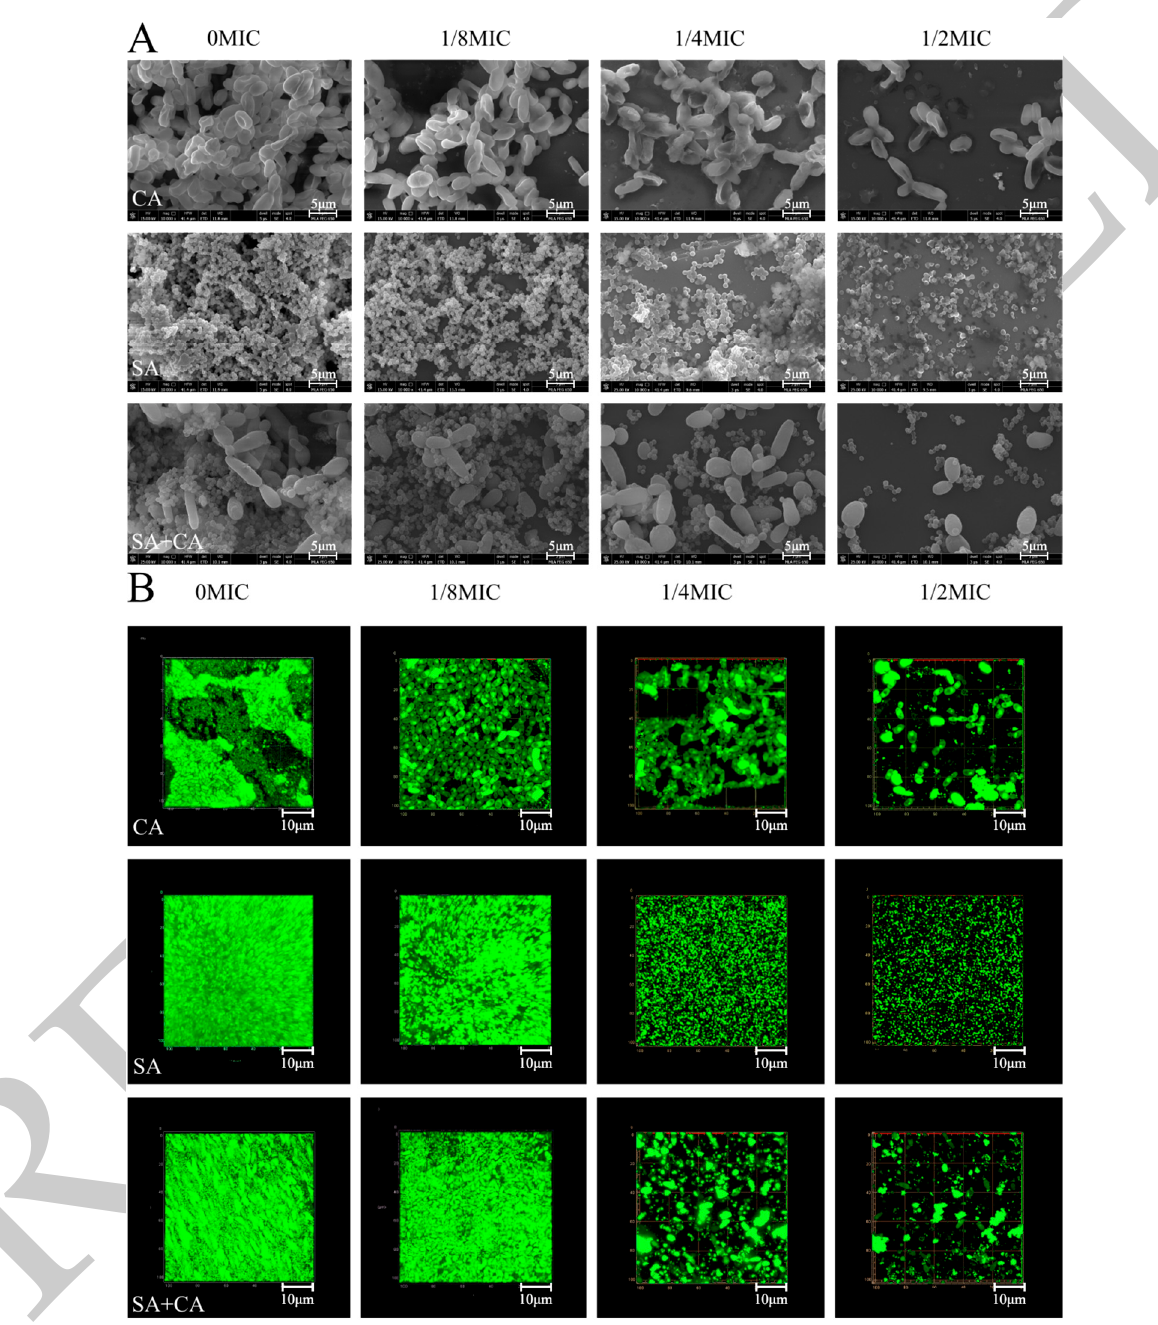
Figure 2. Examination of inhibitory effects of sub-MIC sanguinarine on C. albicans SC5314 (CA) and S. aureus CMCC26003 (SA) mono- and dual-species (SA+CA) biofilms by field emission scanning electron microscopy (FESEM, A ) and confocal laser scanning microscopy (CLSM, B ). Scale bars represent 5 μ m for FESEM and 10 μ m for CLSM, respectively.